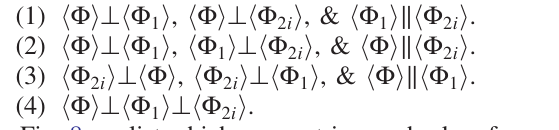
¯ XMX Þ which Φ 1 couples to. We assume that only h Φ y 1 i ≠ 0